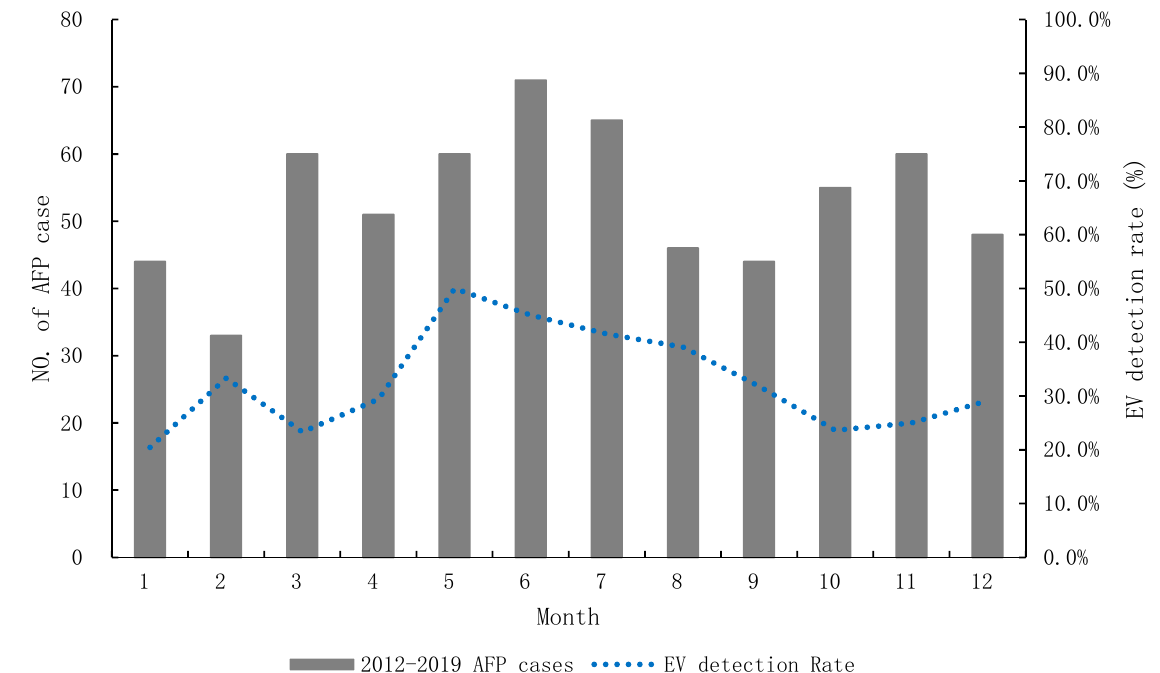
Figure 1. Monthly detection rate of AFP surveillance in Korea, 2012–2019. The bar graph shows the monthly number of AFP patient cases, and the line graph displays the NPEV detection rate in the AFP surveillance system, 2012–2019. The diagnoses of patients with AFP were diverse, including meningoencephalitis reported in 189 cases (29.7%), followed by Guillain-Barr é syndrome (GBS) in 144 cases (22.6%), transverse myelitis in 58 cases (9.1%), acute disseminated encephalomyelitis (ADEM) in 44